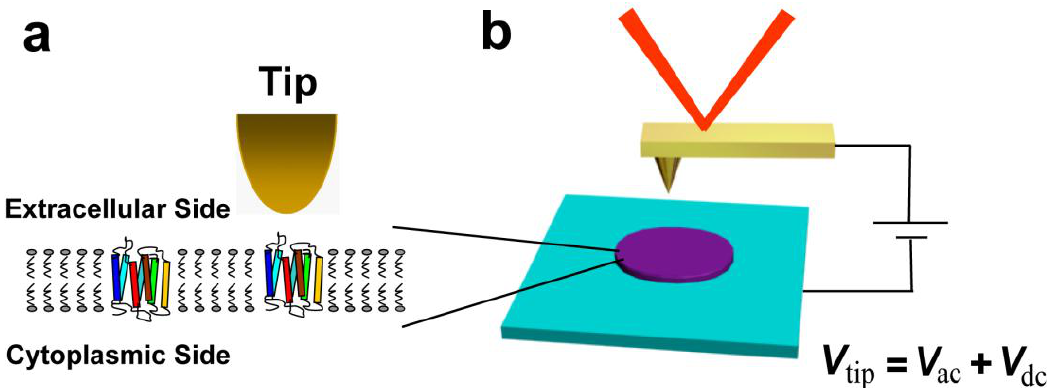
Figure 1. Schematic of ( a ) purple membrane (PM), which consists of bacteriorhodopsin (BR, multicolor) and lipids (gray) only. Oriented PMs are interesting because of their differential electric properties. A BR includes seven- α -helices, C -terminus, and N -terminus; ( b ) Electric force microscope. PMs are deposited on a highly doped silicon substrate randomly oriented face down. Sample topography and electric properties are imaged simultaneously.